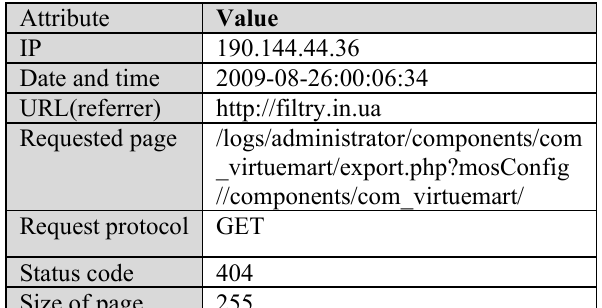
Table 4. Contents of The Log File Used